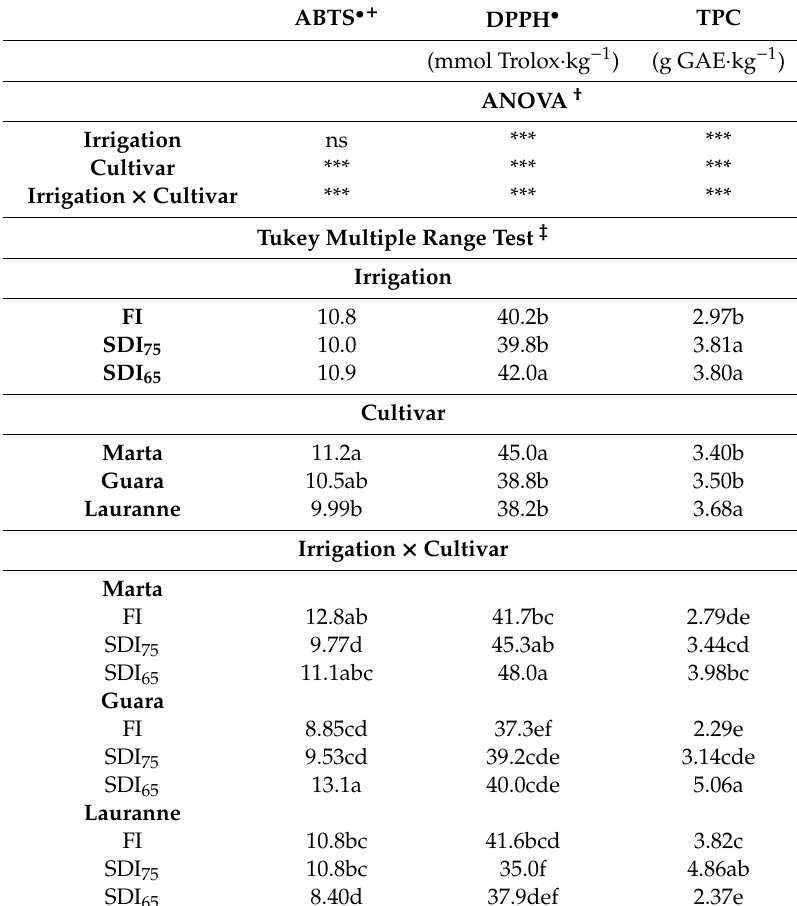
Table 3. Antioxidant activity (ABTS • + and DPPH • indices) and total phenolic content (TPC) for di ff erent cultivars and irrigation